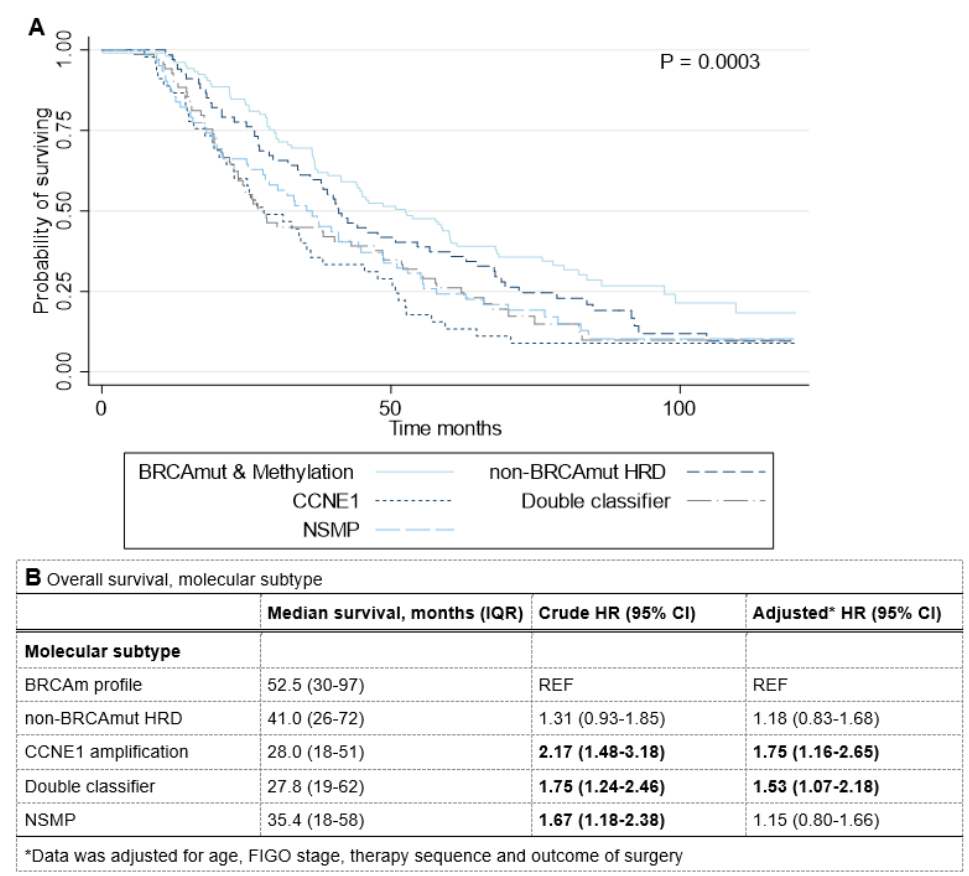
Figure 3. Survival analyses of patients with HGSOC, according to molecular profiles. ( A ) Kaplan– Meier curves for overall survival according to molecular profiles. p values were derived with the use of the log-rank statistic. ( B ) Multivariable analysis for overall survival per molecular subtype. Abbreviations: BRCAm profile: BRCA mutation or BRCA1 promotor methylation; HRD: